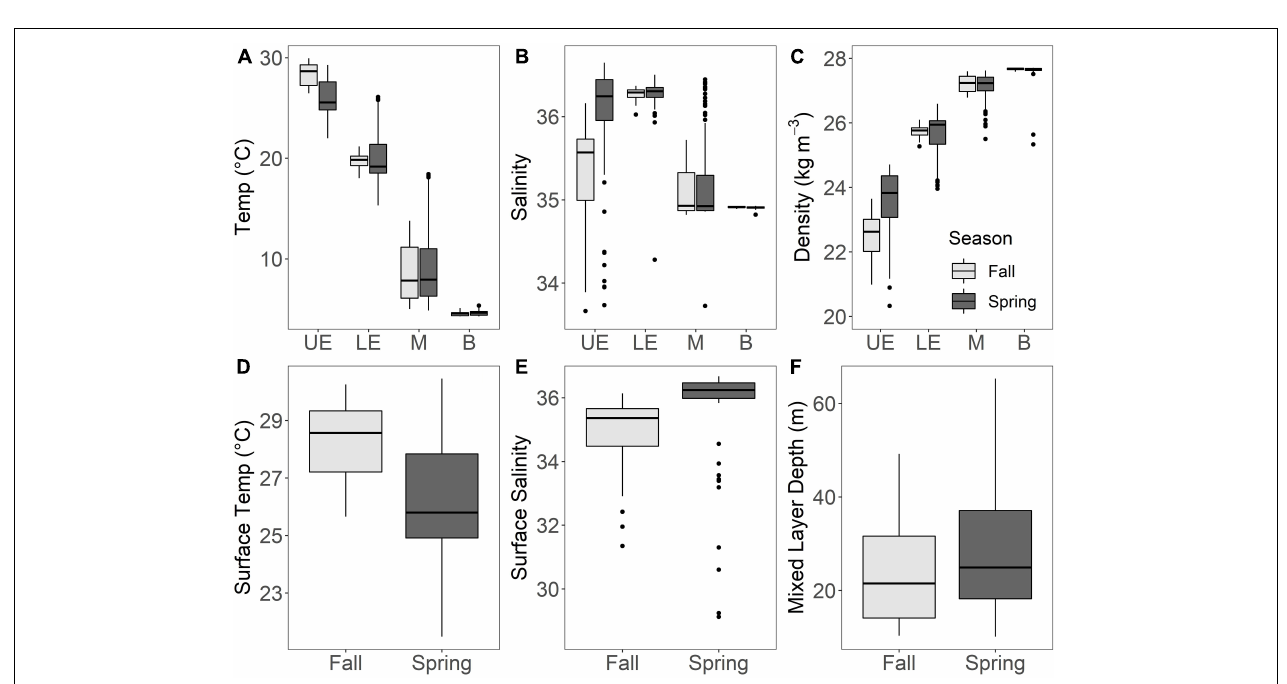
FIGURE 3 | Environmental variability in the northern Gulf of Mexico among pelagic zones and seasons for (A) temperature, (B) salinity, and (C) density measured with each net sample. Surface feature variability between seasons was shown for (D) surface temperature, (E) surface salinity, and (F) mixed layer depth associated with each tow. UE, upper epipelagic (0–25 m); LE, lower epipelagic (25–200 m); M, mesopelagic (200–1,000 m); B, bathypelagic (1,000–1,500 m). Boxplots display the median value (horizontal line), 25th and 75th percentiles (lower and upper hinges, respectively), and the extent of the whiskers from each hinge represents 1.5